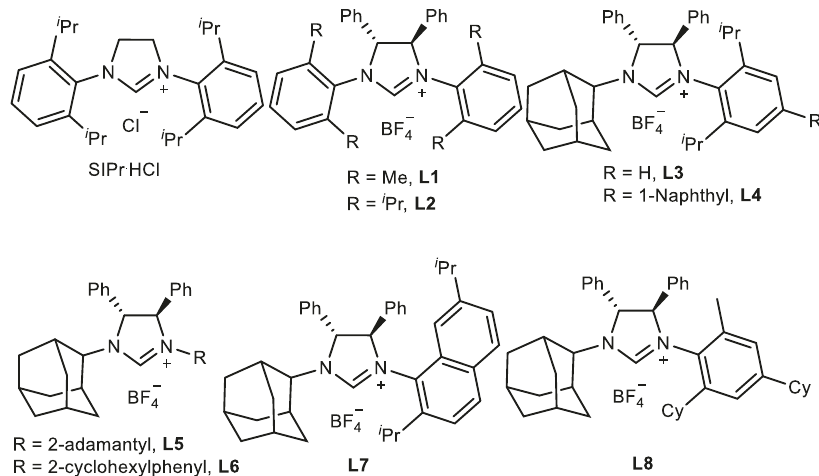
Fig. 4 N -Heterocyclic carbenes. Structures of NHC ligands L1 – L8 tested in Table 1.